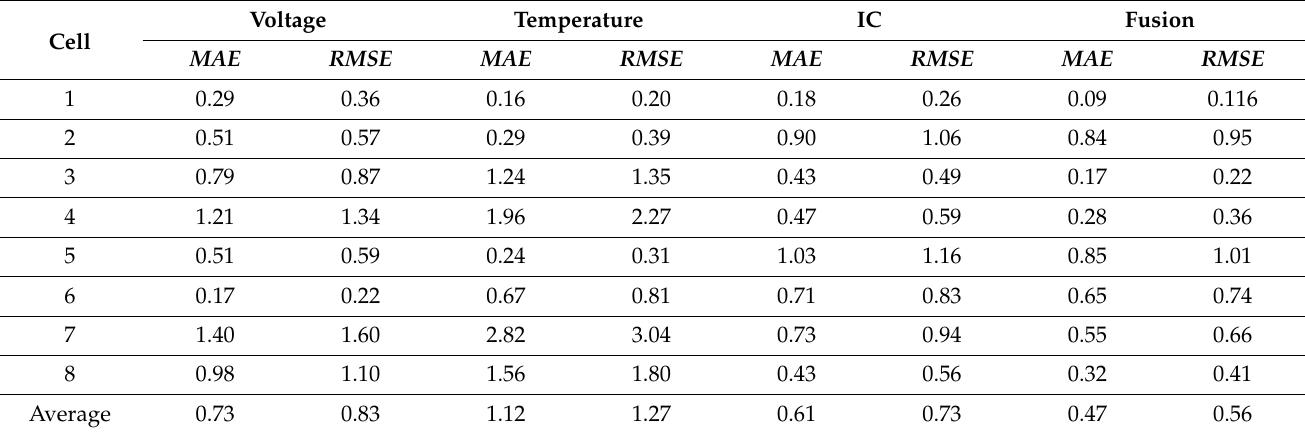
Figure 11. SOH estimation results of different feature extraction strategies. Table 3. Summary of MAE and RMSE of different feature extraction